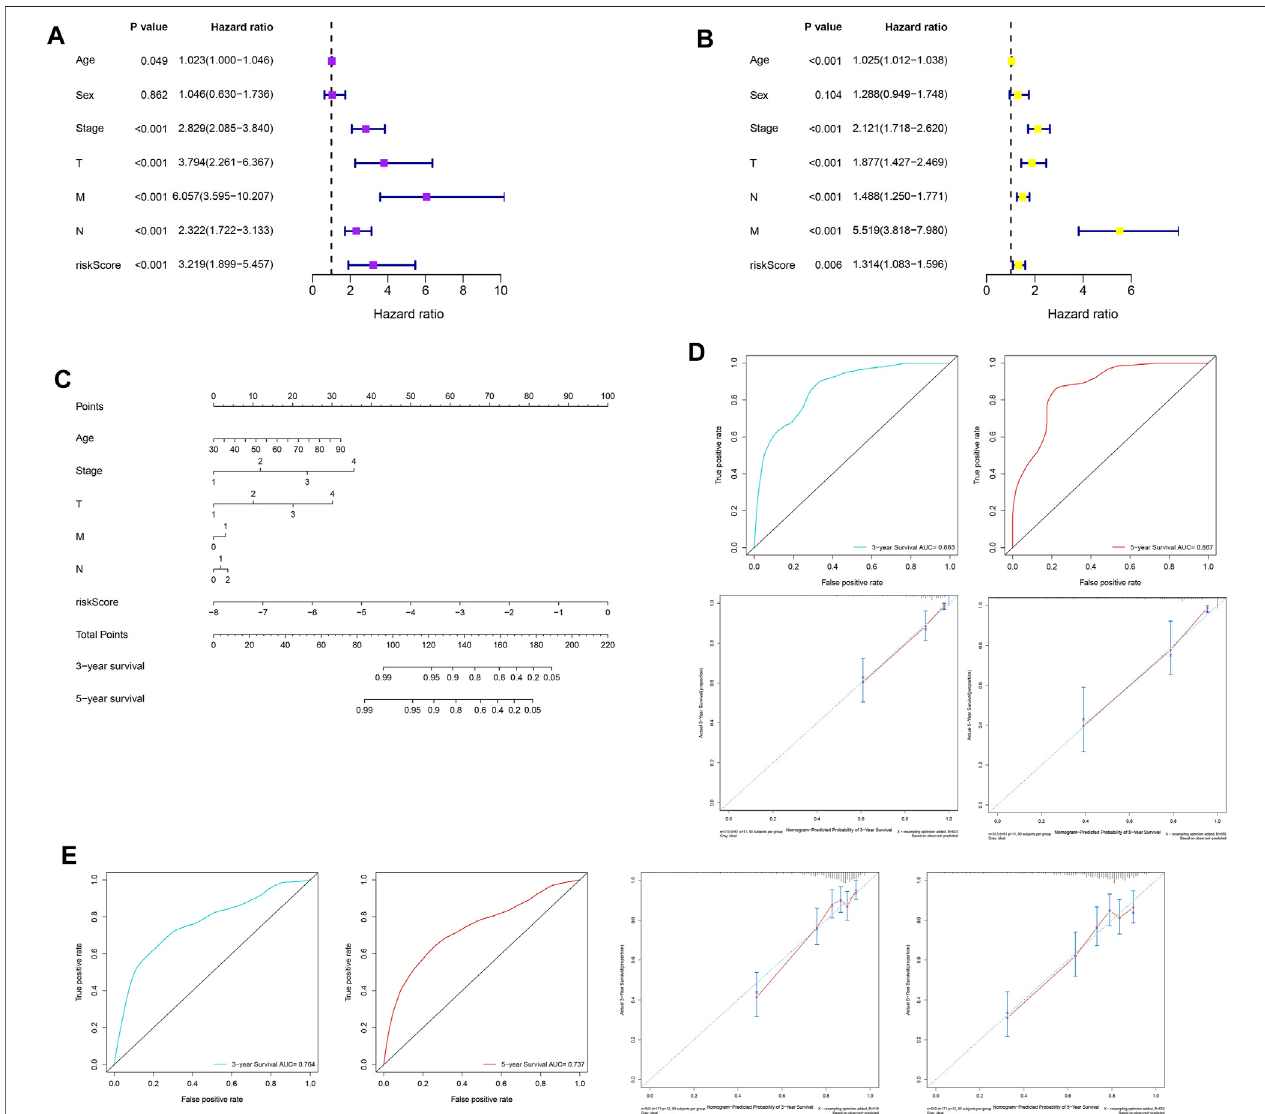
FIGURE 8 | Construction, evaluation, and validation of a nomogram. Univariate analysis based on (A) the training set and (B) the validation set. (C) A nomogram was constructed on the basis of the training set. (D) In the training set, the areas under the ROC curves for predicting 3- and 5-year OS. (E) Calibration curves for predicting 3-and 5-year OS ofpatients in thetraining set. (F) The ROCcurvesand calibration curves for 3- and 5-year OSof patients in the validation set. ROC, receiver operating characteristic; OS, overall survival.